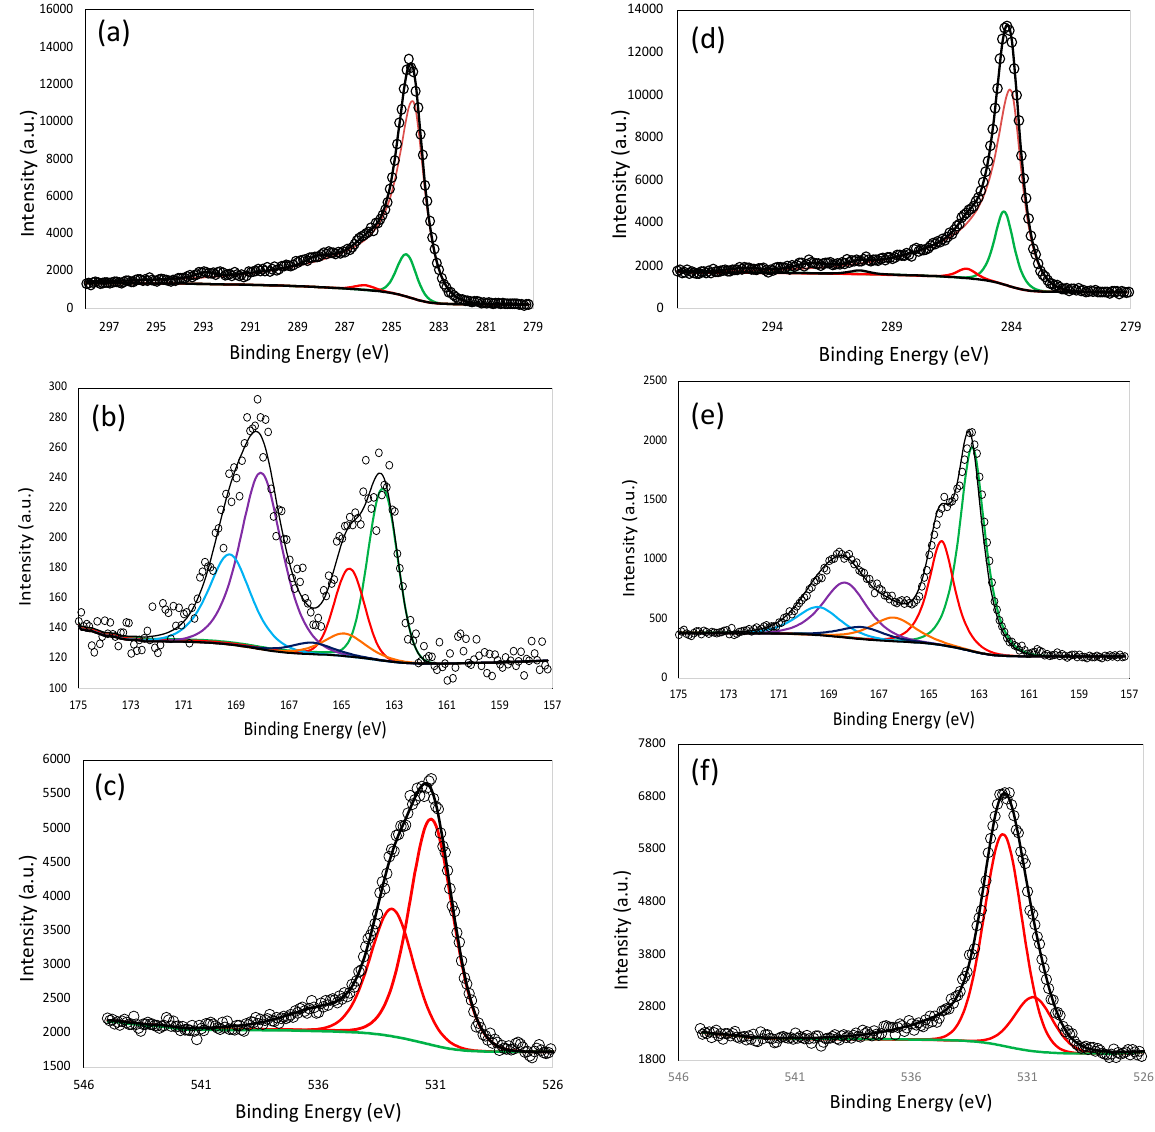
Figure 3. X-ray photoelectron spectroscopy (XPS) analysis; peak deconvolution results of C-1s ( a ), S-2p ( b ), and O-1s ( c ) of LS-3; and C-1s ( d ), S-2p ( e ), and O-1s ( f ) of LS-5. Table 3. XPS-based quantitative functionalities C, O, and S in LS-1 to -5.